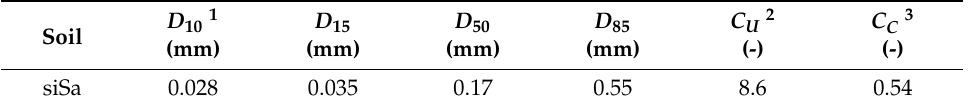
Table 3. Particle size characteristics of the soil tested.